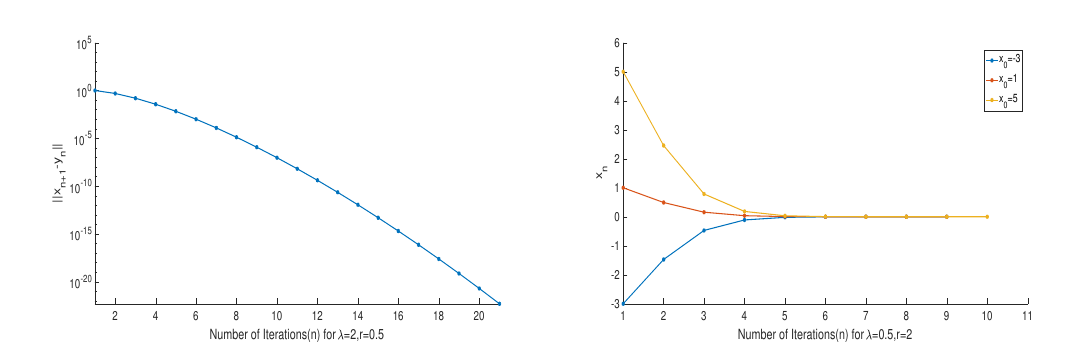
Figure 1. Values of x n and y n for different λ and r .